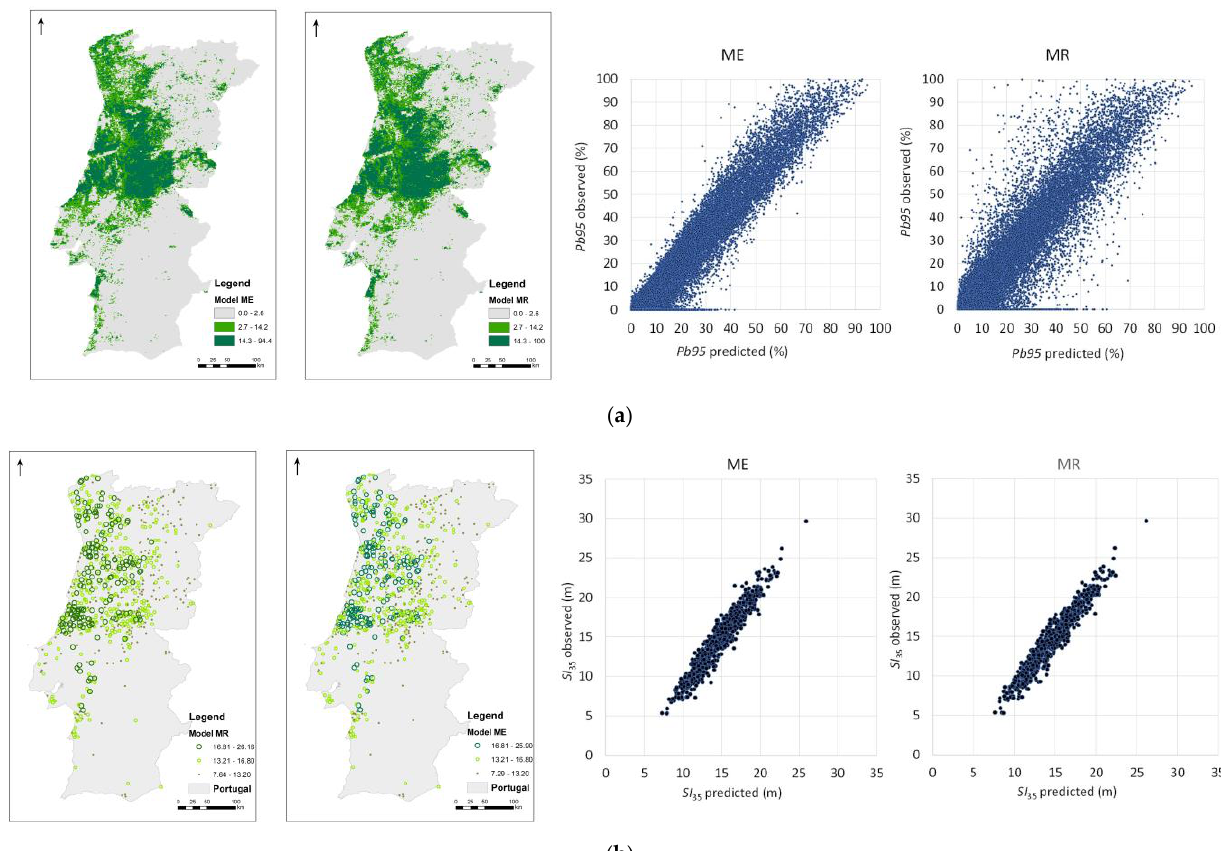
Figure 3. ML models maps and residuals: ( a ) species distribution maps ( Pb95 ) and residual for ME and MR models simulations; and ( b ) species productivity maps ( SI 35 ) and residual for ME and MR model simulations.